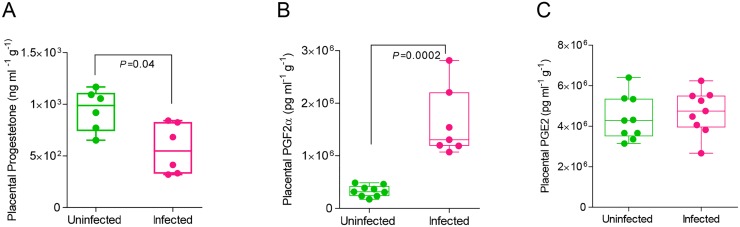
Infection increases placental expression of contraction-inducing PGF2α and reduces pregnancy-supportive progesterone.Placental lysates were isolated from uninfected and infected pregnant mice (E16). Hormone expression was quantified via ELISA for A. progesterone (N = 6 per group); B. prostaglandin F2α (PGF2α) (N = 9, uninfected, N = 7, infected) and C. prostaglandin E2 (PGE2) (N = 9 per group). Student’s t-test was performed between selected groups and significance noted above asterisk brackets.